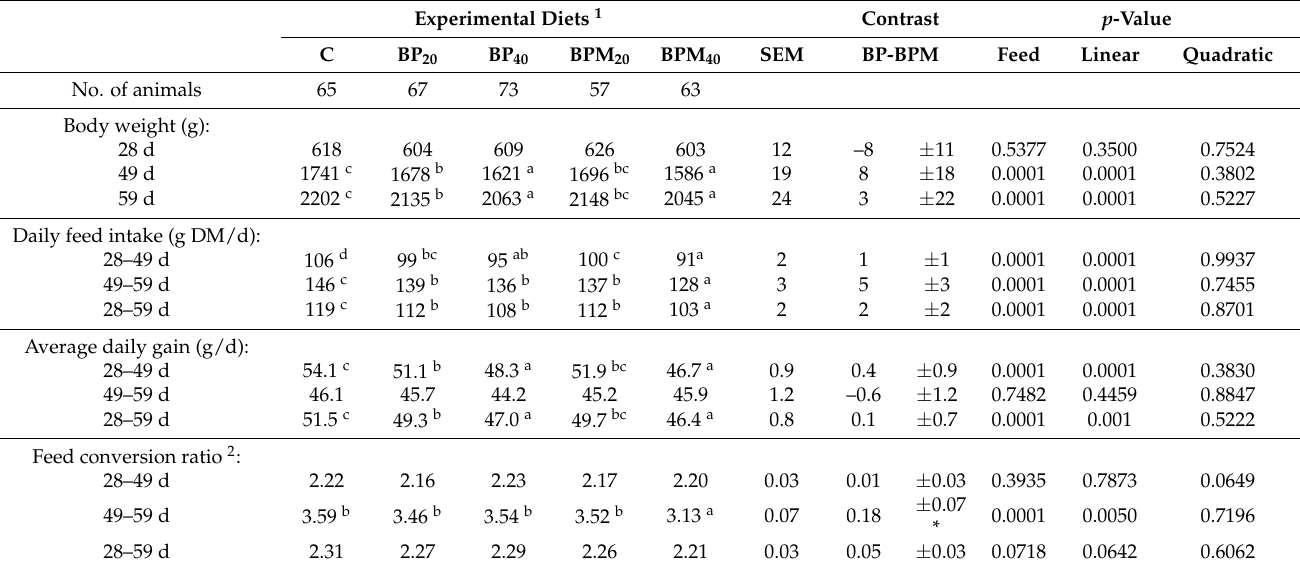
Table 3. Effect of beet pulp inclusion (with or without molasses) on the growth performance of fattening rabbits.